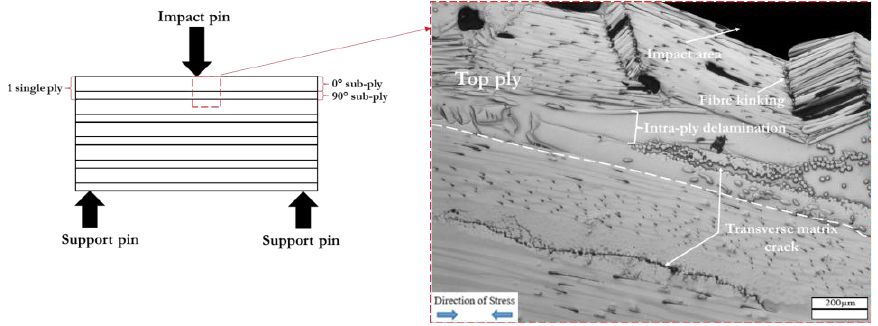
Figure 6. Typical failure modes on the compression side of a NCF basalt/epoxy composite under bending loads.